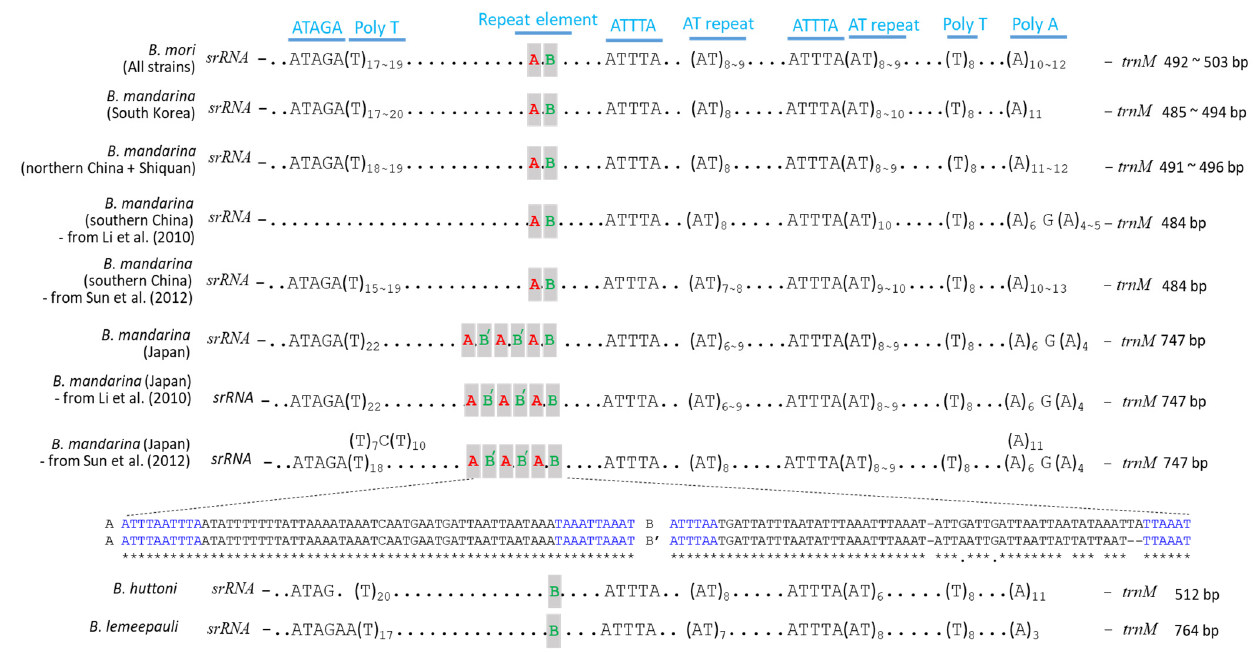
Figure 2. Schematic illustration of the A + T-rich region of Bombyx mori and B. mandarina . The presented nucleotides indicate conserved sequences, such as the ATAGA sequences and abutting poly-T stretches, ATTTA sequences, AT repeats, ATTTA and abutting AT repeats, poly-T stretches, and poly-A stretches. Dots between sequences indicate omitted sequences. Subscripts indicate the repeat number. The 126 bp repeat element, comprised of subunit A (~64 bp) and subunit B (~62 bp), each of which is flanked by 10 bp perfect inverted repeats or 6 bp perfect inverted repeats (blue color), is presented. Note that all B. mandarina from Japan have a triplicated 126 bp repeat, whereas the remaining B. mandarina and B. mori have a single 126 bp repeat, and B. huttoni and B. lemeepauli have only subunit B. Where necessary, the origin of sequences and corresponding references are